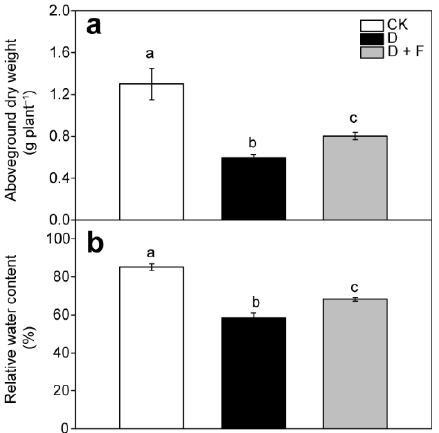
Figure 1. Aboveground biomass ( a ) and leaf relative water content ( b ) in leaves of B. napus treated with different fullerol treatments (0 and 100 mg L −1 F) and water gradients (CK: check, sufficient water condition; D: drought). Values are the means of three replicates ± standard error. The different letters in each subfigure indicate significant differences between water or fullerol treatments. Data were adapted from Xiong et al. [9].